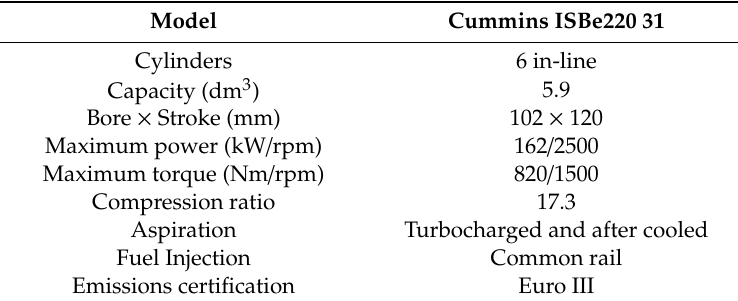
Table 1. Engine specifications.